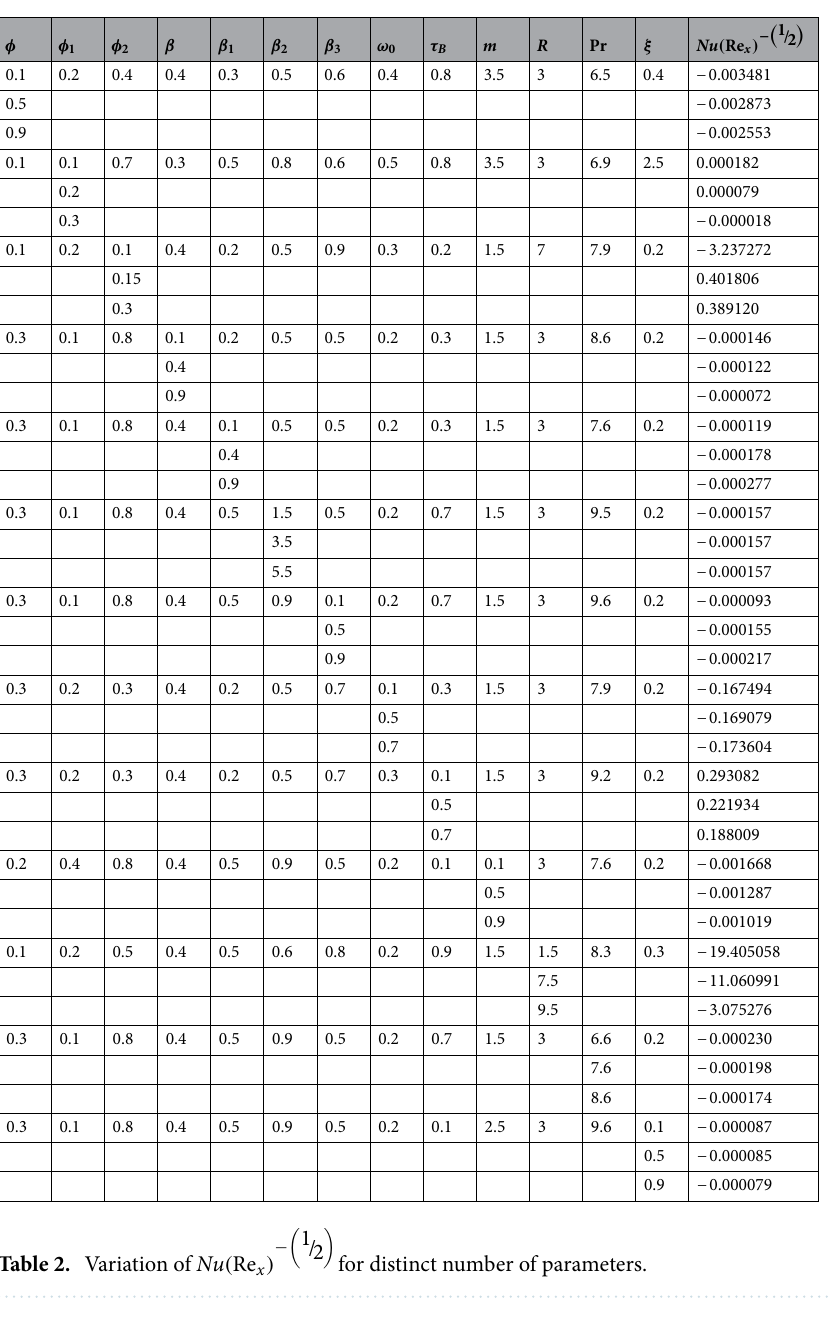
Table 2. Variation of Nu ( Re x ) − (cid:31)